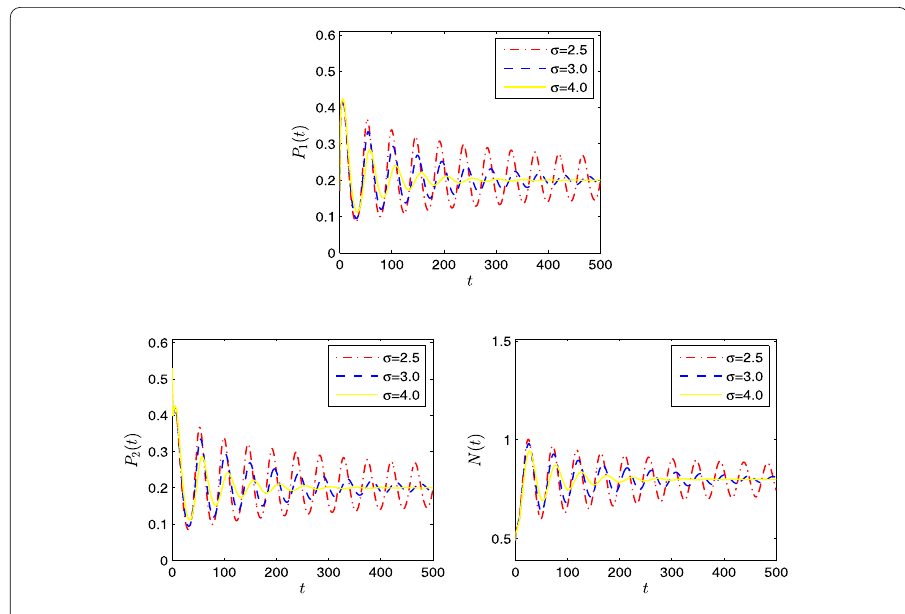
Figure 10 The effects of feedback delay σ on system (35)